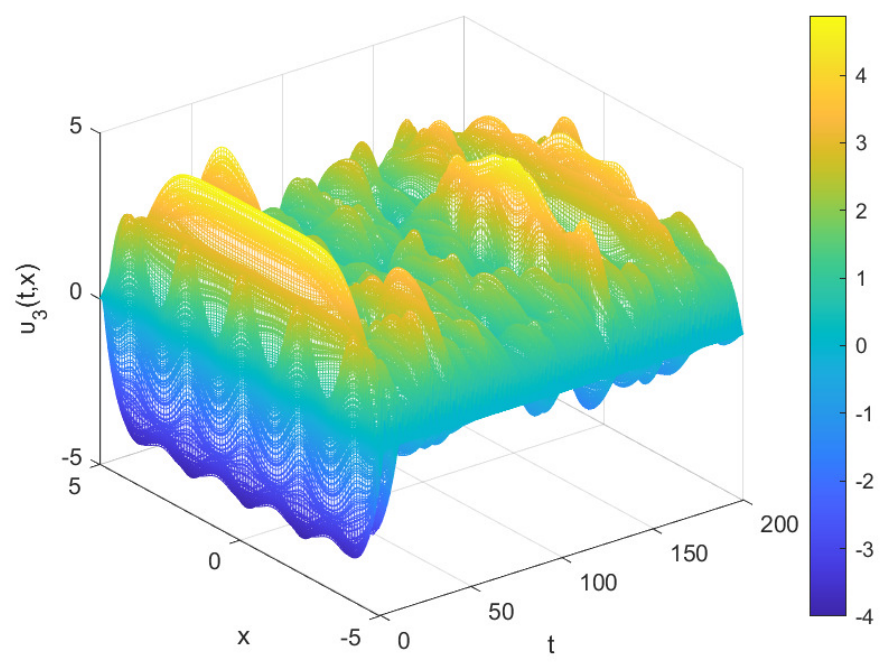
Figure 3. Time valuation of υ 3 ( t , x ) in system